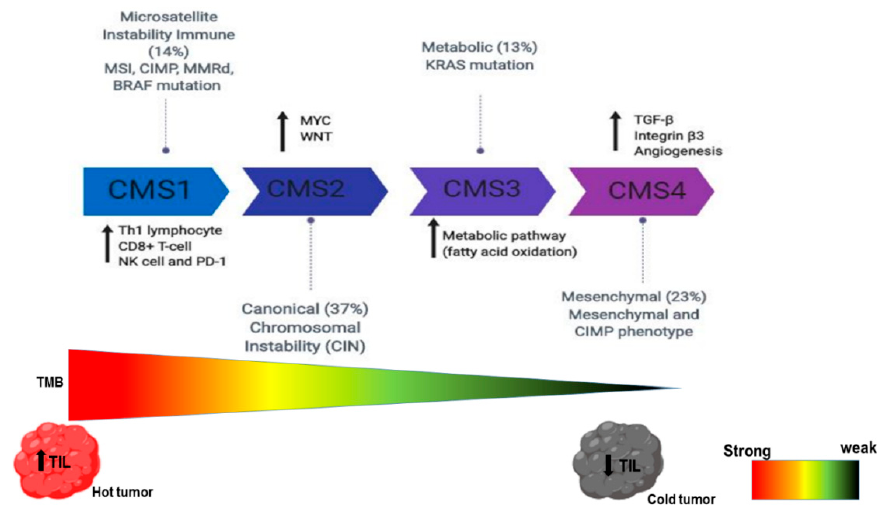
Figure 5. The consensus molecular classification (CMS) of CRC in correlation with tumor infiltrating lymphocyte (TIL) abundance. CMS1 is infiltrated with T helper 1 lymphocytes, CD8 + T cells, NK cells, PD-1, tumor mutation burden (TMB) and increased TIL as compared with other CRC subtypes. High TIL infiltration represent a hot tumor, which can be targeted with an immune checkpoint inhibitor, whereas reduction in TIL denotes a cold tumor.